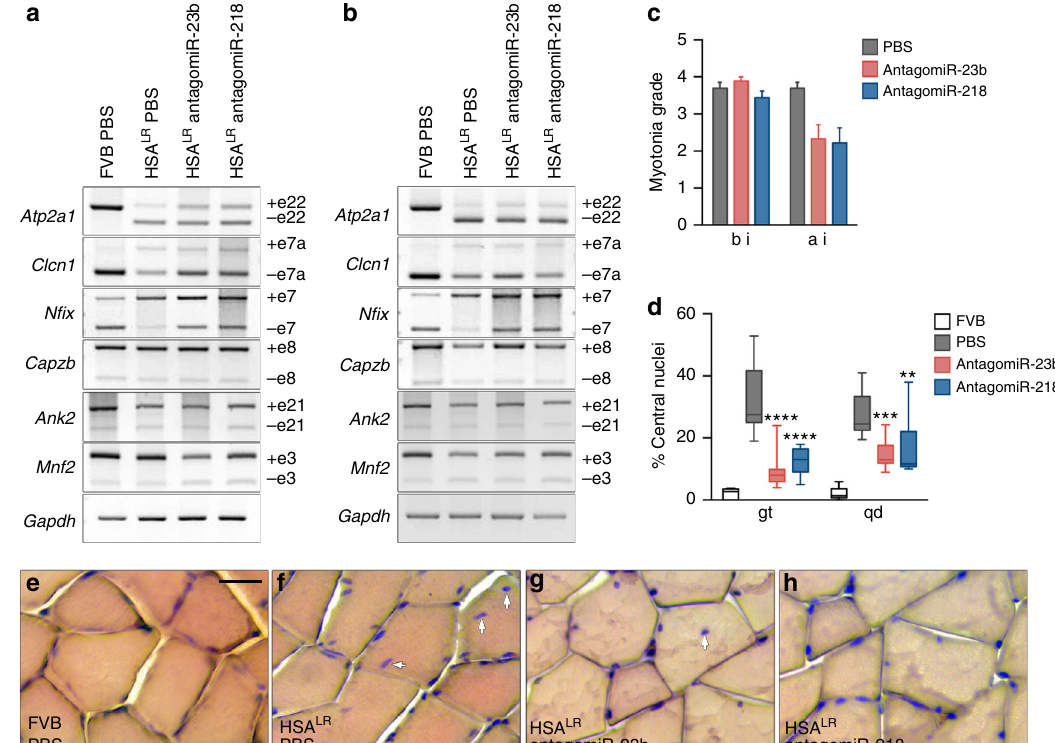
Fig. 6 Systemic delivery of antagomiRs improved missplicing of Mbnl-dependent transcripts, myotonia, and muscle histopathology in HSA LR mice. a , b RT- PCR analyses of the splicing of Atp2a1 exon 22, Clcn1 exon 7a, N fi x exon 7, Capzb exon 8, Ank2 exon 21, and Mnf2 exon 3 in gastrocnemius (gt) ( a ) and quadriceps (qd) ( b ) muscles. Gadph values were used for normalization in the quanti fi cation of the exon inclusion in Supplementary Figs. 9 and 11. c Electromyographic myotonia grade in antagomiR (pink and blue bars) or PBS-treated (gray bars) HSA LR mice before (bi) and 4 days after injection (ai). Data are mean ± SEM. d Quanti fi cation of the percentage of muscle fi bers with central nuclei in gt and qd muscles of control FVB (white bar), and PBS (gray bar) or antagomiR-treated (pink and blue bars) HSA LR mice. e – h Representative hematoxylin and eosin staining of gt muscles from all four groups of mice. Arrows point to examples of centrally located nuclei in muscle fi bers. Scale bar = 50 μ m. The data were analyzed by unpaired Student ’ s t test compared to untreated HSA LR mice. Data are media ± SEM. * p < 0.05; FVB ( n = 3), HSA LR PBS ( n = 5), HSA LR antagomiR-23b ( n = 4) and HSA